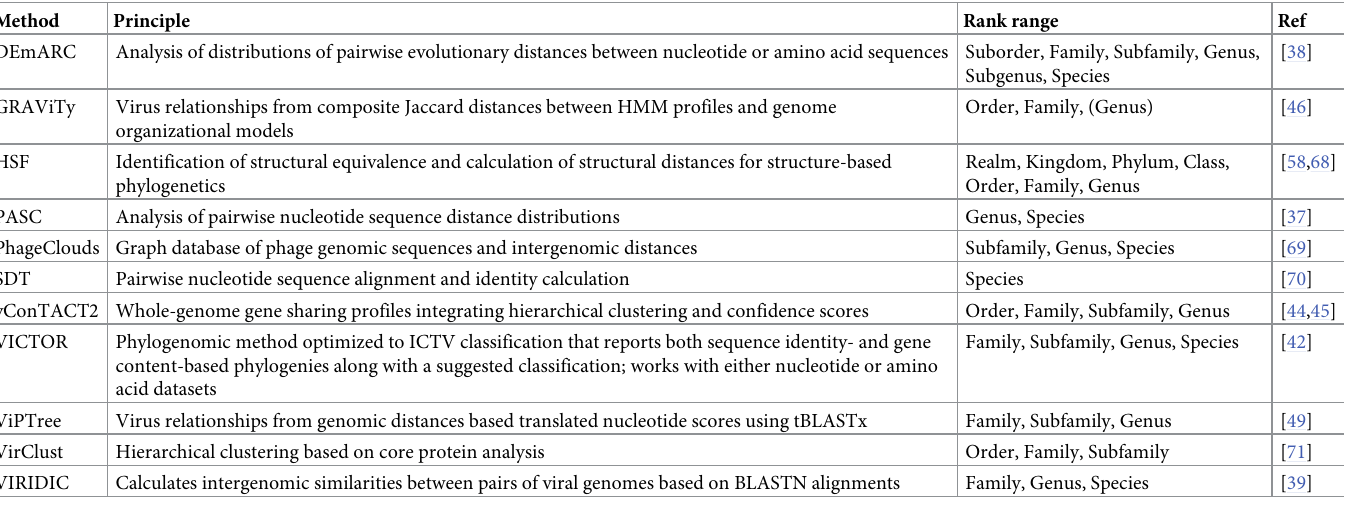
Table 1. Examples of methodologies used for virus classification at different taxonomic ranks � .